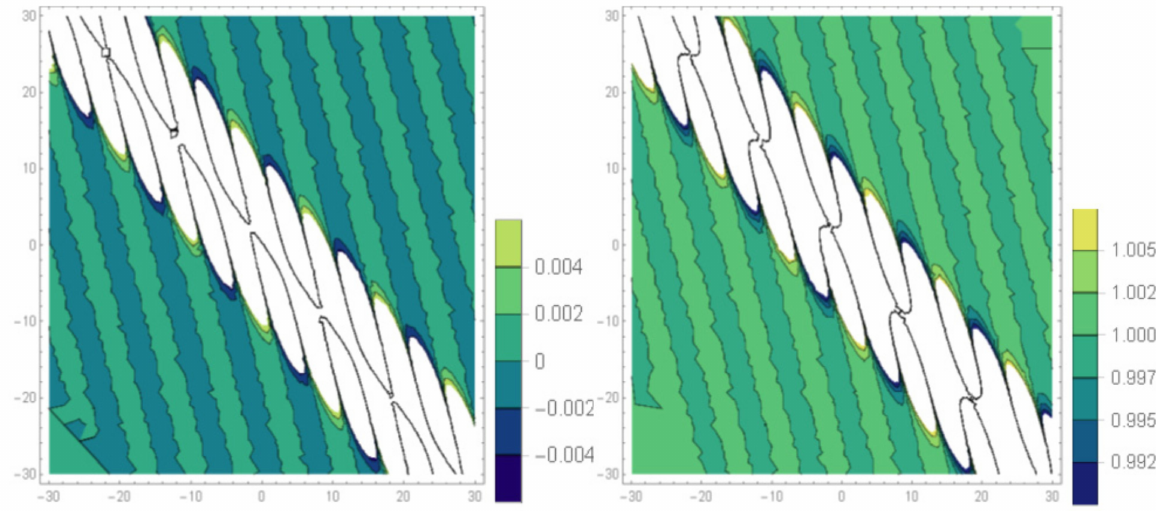
Figure 6. The contour surfaces of Equation (20) under the values of ε = 0.4, − 30 < x < 30, − 30 < t < 30.